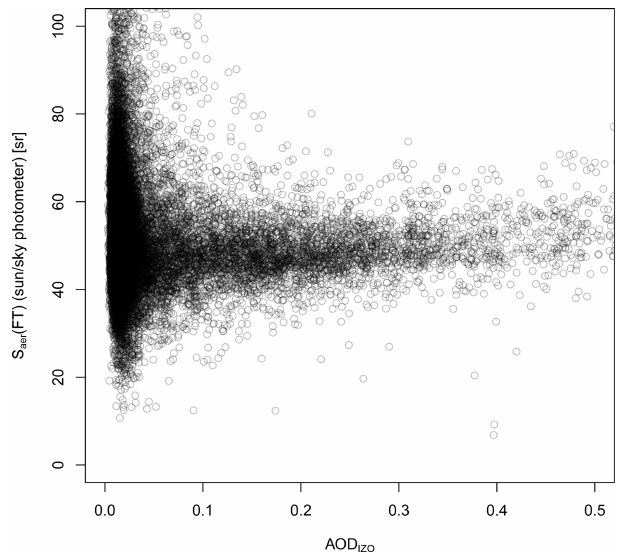
Figure 6. Lidar ratio at 523nm from the sun–sky photometer in- stalled at Izaña Observatory against